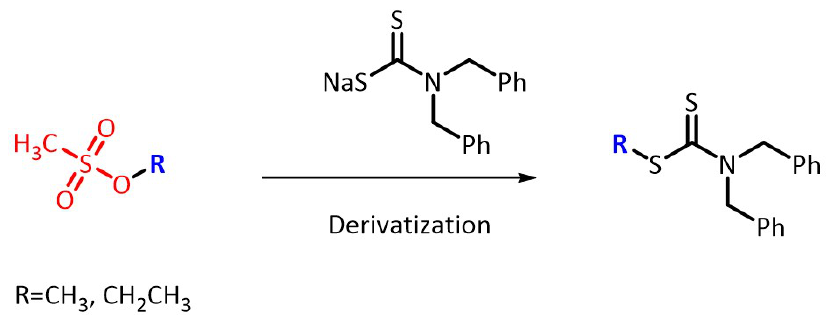
Figure 2. The derivatization reaction of the methanesulfonates with BDC.